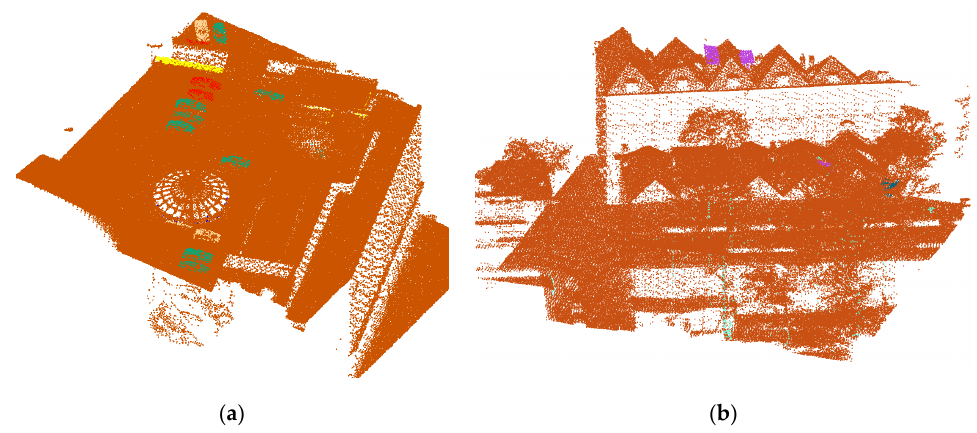
Figure 7. Connected components of changed objects are classified based on their context. ( a ) 2008 vs. 2010; ( b ) 2010 vs. 2012.